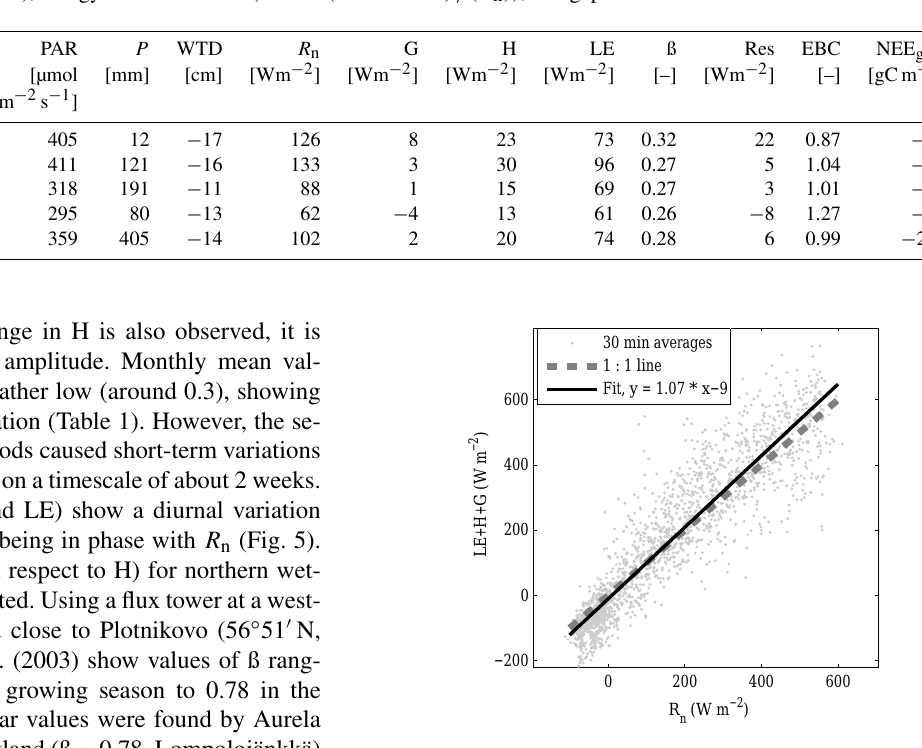
Table 1. Monthly averages of air temperature ( T a ) , soil temperature at 5cm depth ( T p ) , photosynthetic active radiation (PAR), cumulative precipitation (mm), net radiation ( R n ) , ground heat flux (G), sensible heat flux (H), latent heat flux (LE), Bowen ratio (ß), energy balance